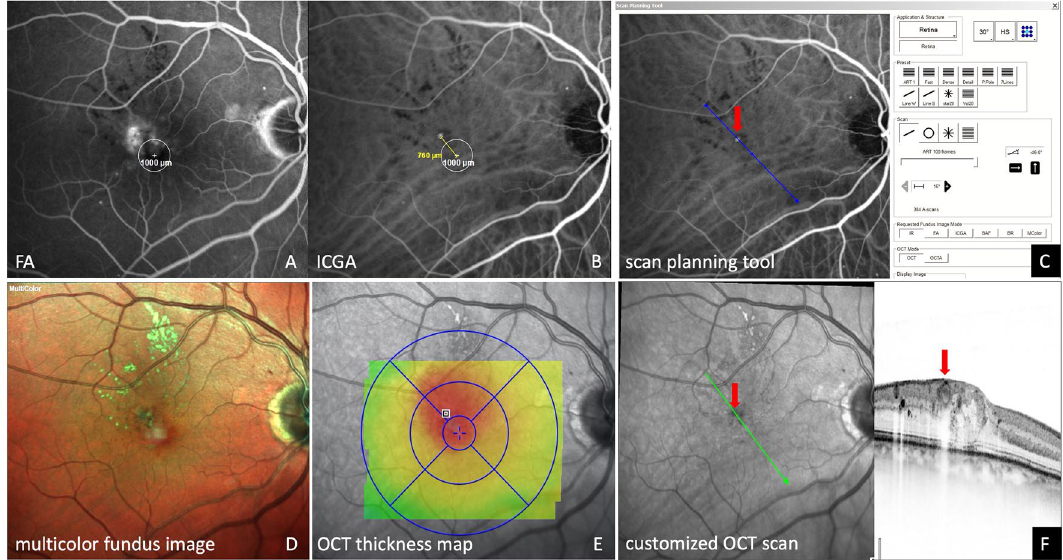
Figure 1. Multimodal imaging of a patient with treatment-naive diabetic macular edema (DME) before indocyanine green angiography (ICGA)-guided and OCT monitored laser therapy. A circle with a radius of 500 µm is positioned in the center of the foveal avascular zone (FAZ) as determined with fluorescein angiography (FA) ( A ). Due to simultaneous acquisition of FA and ICGA images, measurements from FA can accurately be transferred to the ICGA image, thus enabling precise distance measurements from the center of the FAZ to the teleangiectatic capillary (TC) ( B ). Mid- to late-phase ICGA depicts one TC 760 µm from the foveal center. Diffuse leakage is seen in the late-phase of FA in and around this area ( A ). The scan planning tool, provided by the OCT systems software, is used to create a customized OCT B-scan centered on the TC based on the patients’ ICGA images ( C ; blue line/red arrow).The TC is clearly visible in the OCT B-scan, showing a hyporeflective lumen, compared with the surrounding vessel wall ( F ; red arrow). This OCT single scan is used for OCT monitoring of the immediate treatment response during and after laser therapy as well as for long-term follow-up. A multicolor fundus image displays hard exudates superotemporal from the TC ( D ). The retinal thickness map, centered on the fovea, presents asymmetrical distribution of the edema with the peak of the edema near the ICGA positive lesion ( E ). Based on this multimodal image data, the patient was scheduled for focal laser therapy (see Fig.